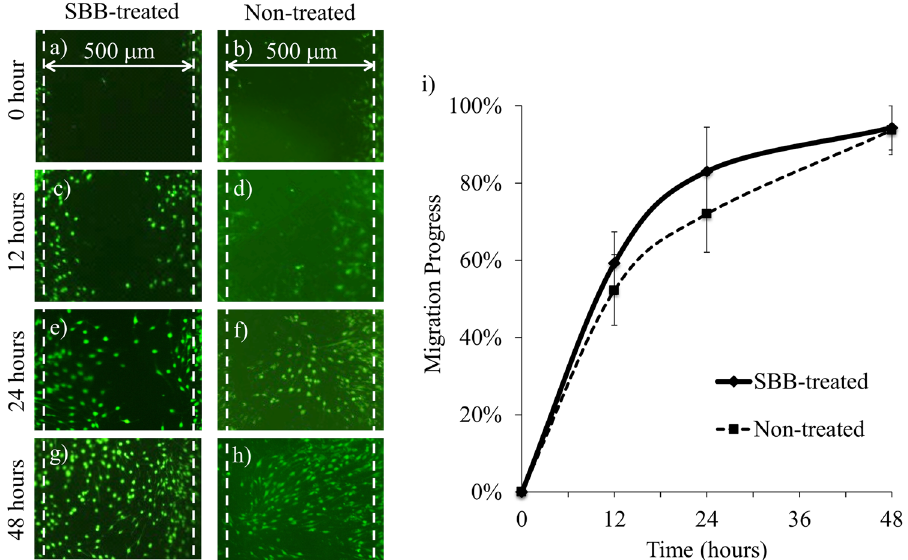
Figure 5. The effect of pre-culture SBB treatment on 3T3 fibroblast migration. ( a – h ) The fluorescence images of NIH/3T3 cells over time. ( i ) The change of 3T3 migration progress over time. At each time point, there was no statistical difference in the migration progress between the SBB-treated and non-treated groups. The width of initial scratch was ~500 μ m. The cells were stained by calcein AM.